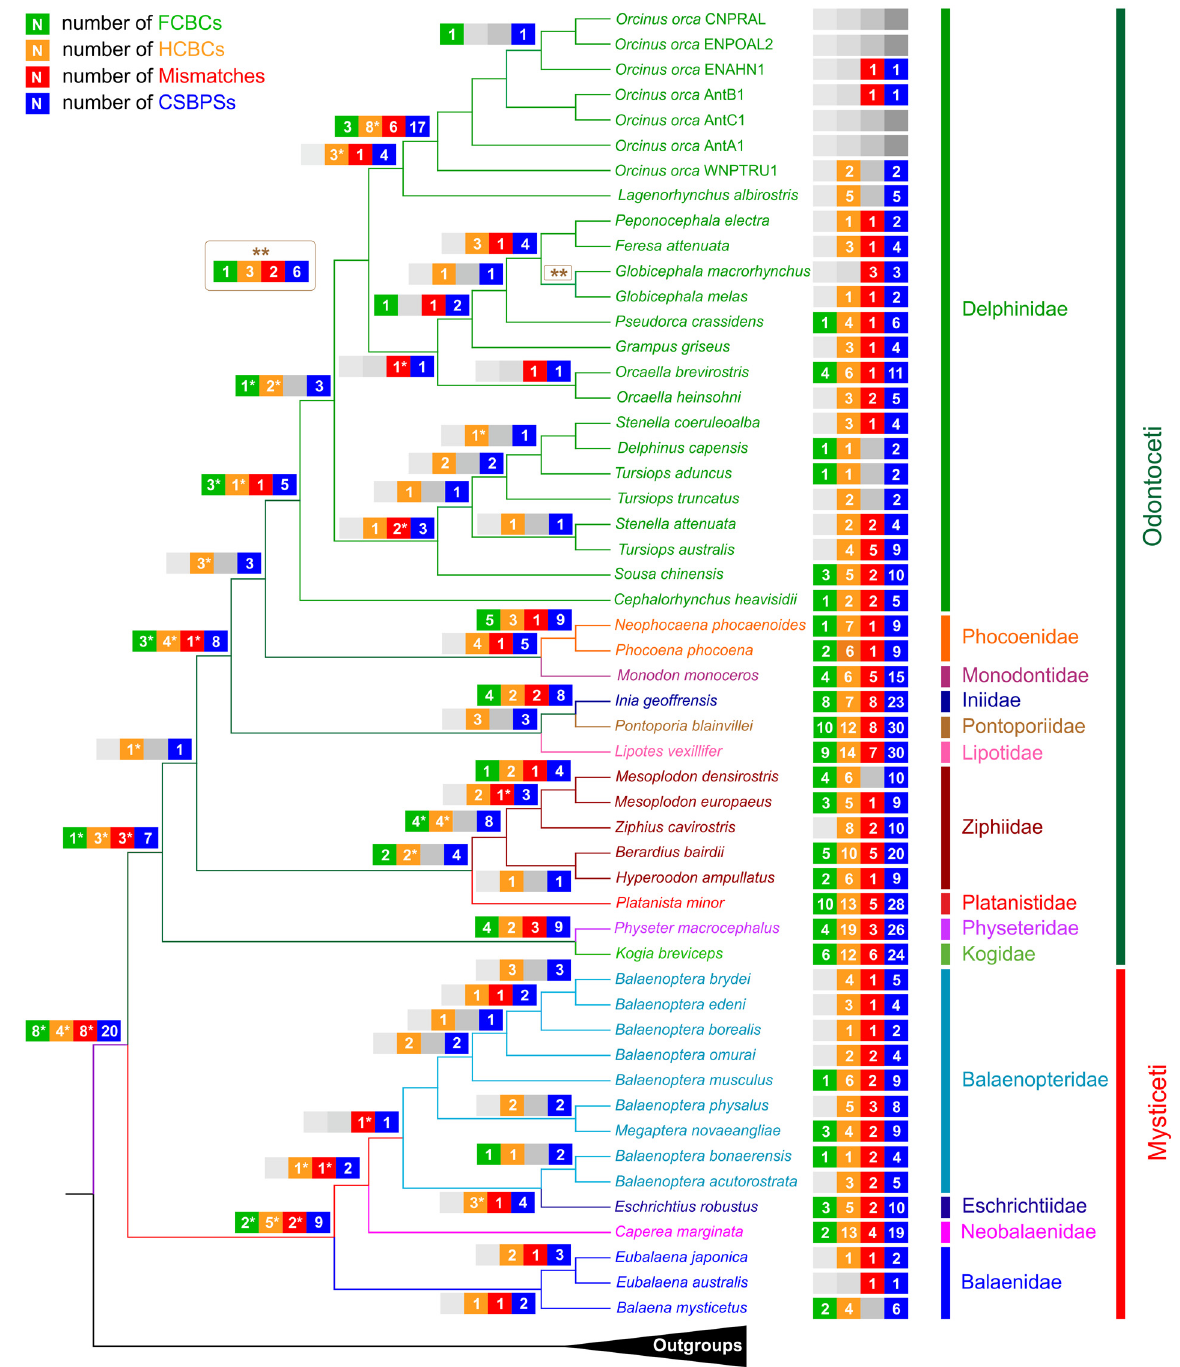
Fig 5. Mapping of CSBPSs in the Cetacea phylogenetic tree. CSBPS, change in sequence in a base pair of a stem; FCBC, fully compensatory base change; HCBC, hemi compensatory base change; Mismatch, mismatch in a base pair of a stem; Number of FCBCs, HCBCs, and Mismatches (included their sum CSBPSs) occurring at the nodes of the reference phylogenetic tree. The asterisk associated with some CSBPS values indicates that these CSBPSs were subjected to successive changes in one/some of the taxa downstream of the considered node. For details on the type of FCBCs, HCBCs, and mismatches occurring at a single node, please refer to S7 – S9 Figs.